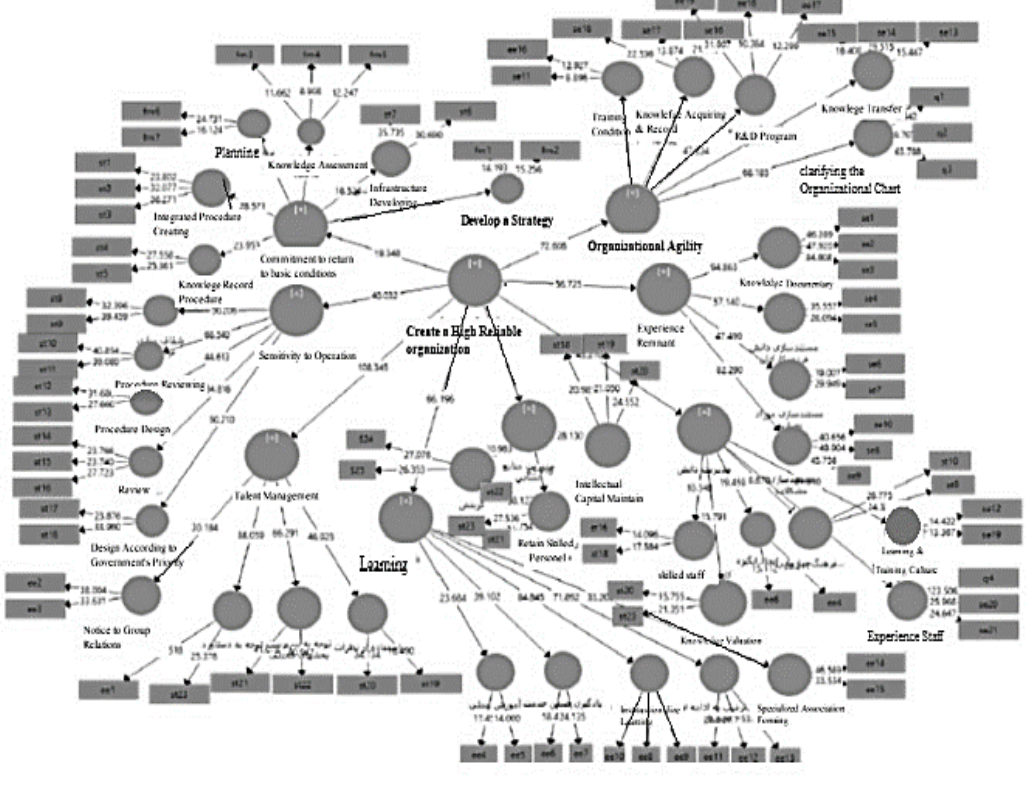
Fig. 4. Structural model output in Smart PLS software (source: software output).